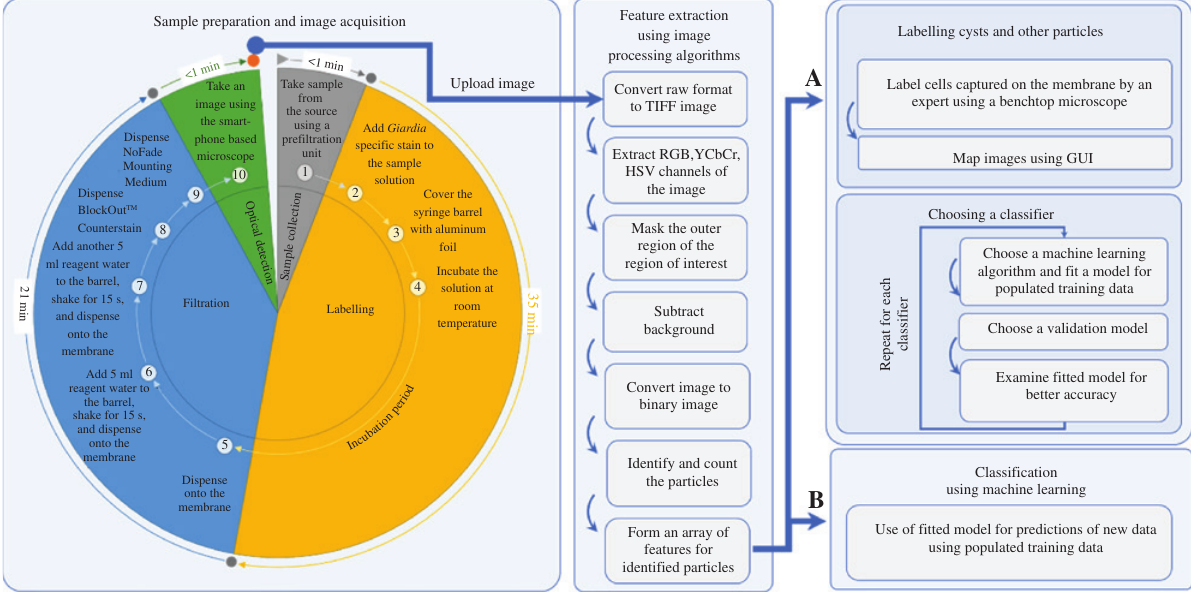
Figure 2: Sample preparation, image processing, and machine learning workflow. (A) Steps for populating a training image database and choosing a classifier model [11]. Following a generally similar approach compared to [11], the sample preparation steps outlined in (A) have been optimized and refined to handle realistic water samples, e.g. tap water and pond water. These optimized sample preparation steps are highlighted with bold letters. The number of steps to prepare a water sample for testing is reduced by using a syringe barrel as a sample collection tube and the total time required for filtration is shortened to 21 min. (B) Steps for automated detection and classification of Giardia cysts using the trained model in